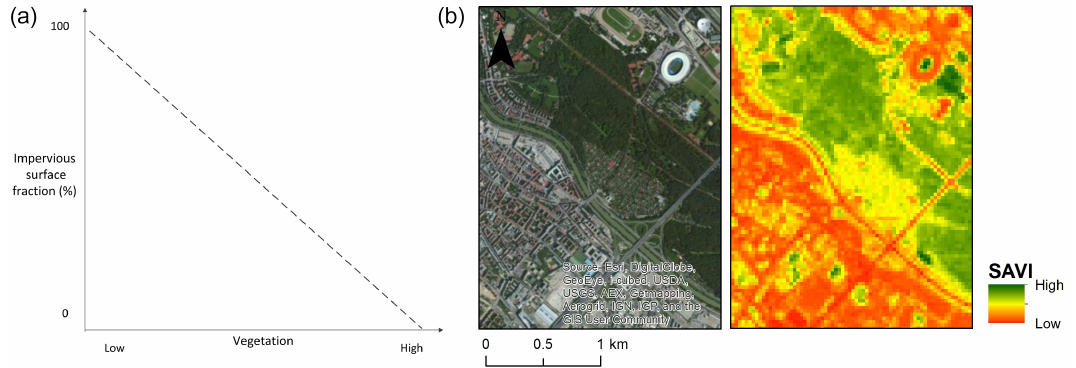
Figure 2. (a) Conceptual relationship between impervious surface fractions and vegetation cover or vegetation indices in urban environments (adapted from Bauer et al., 2008); (b) example of a high-resolution image used to measure impervious surface fractions and soil-adjusted vegetation index (SAVI) calculated from Landsat OLI for a central part of